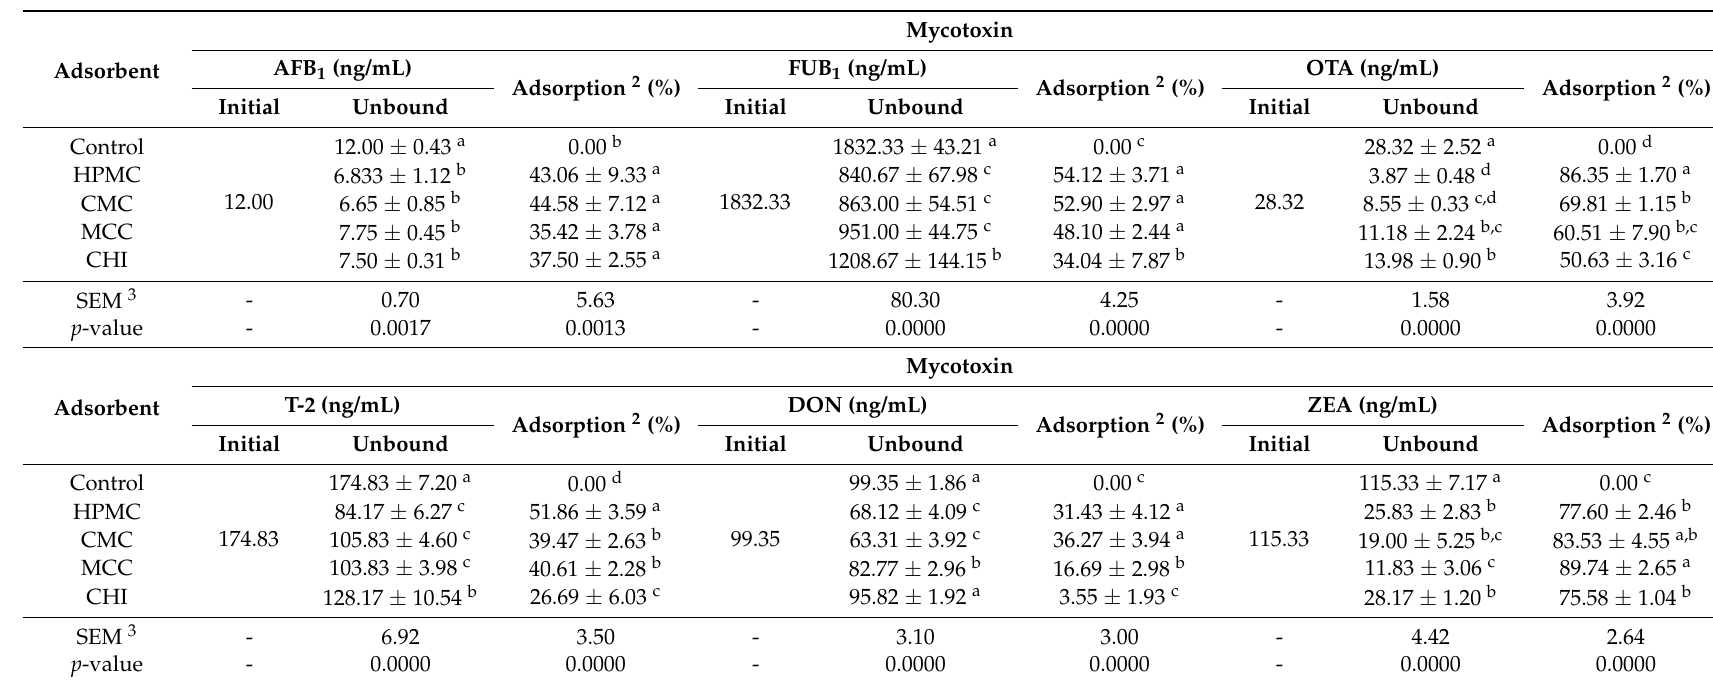
Table 2. Evaluation of adsorbent materials for mycotoxins in an in vitro gastrointestinal model.